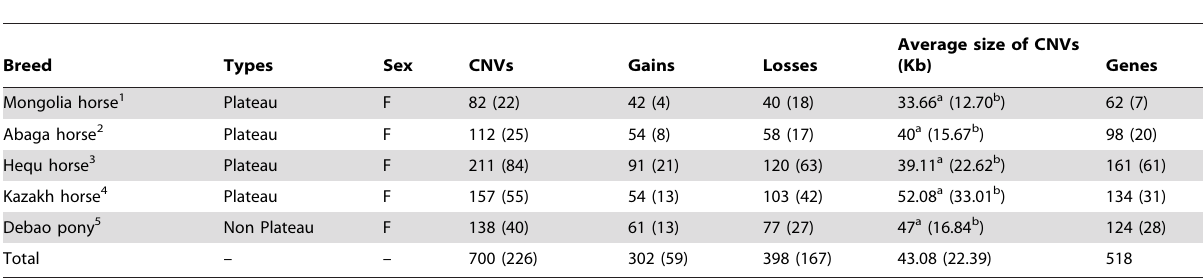
Table 1. The number of detected CNVs with the reference of